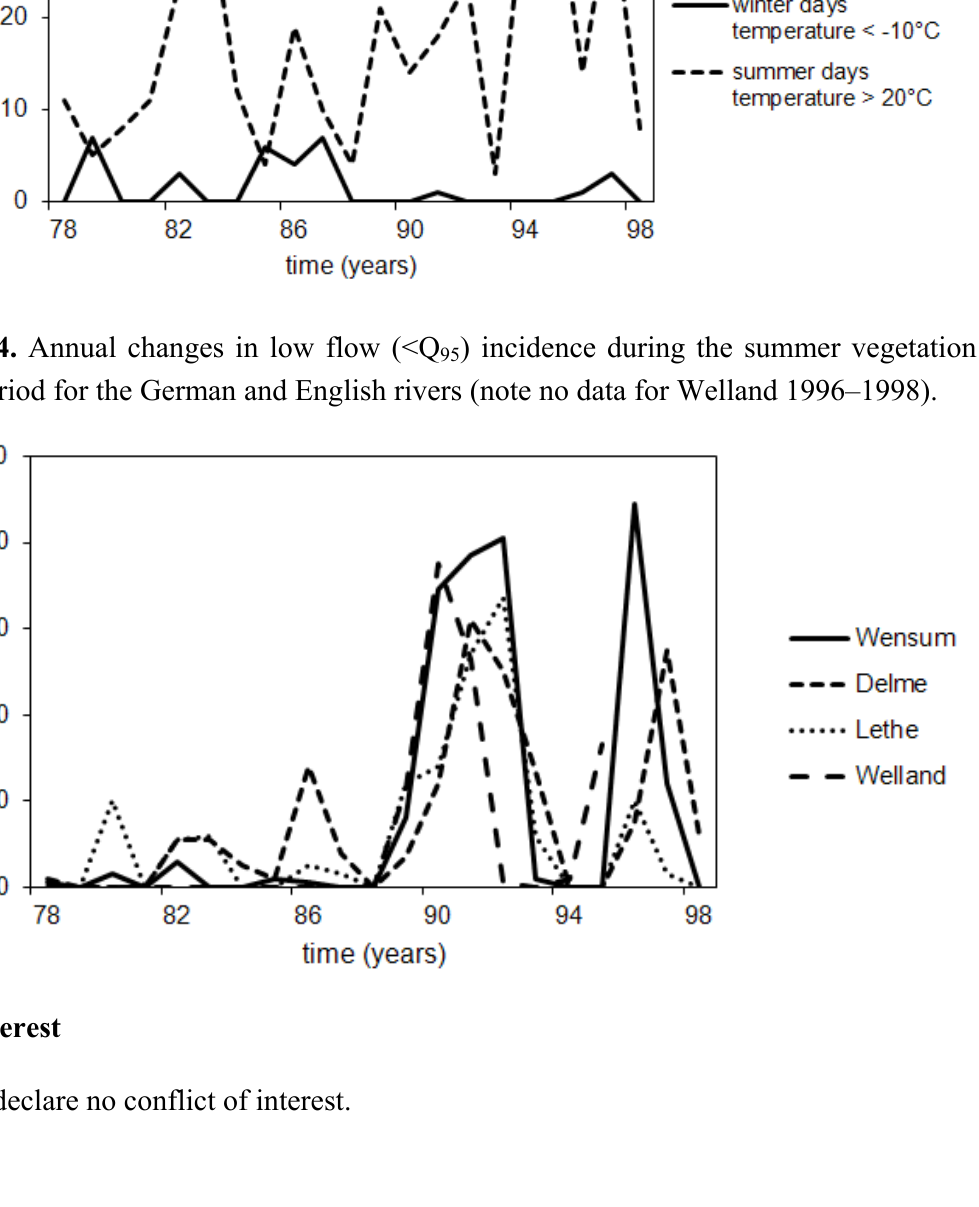
Figure A3. Annual changes in the incidence of mean daily air temperature extremes from Bremen.